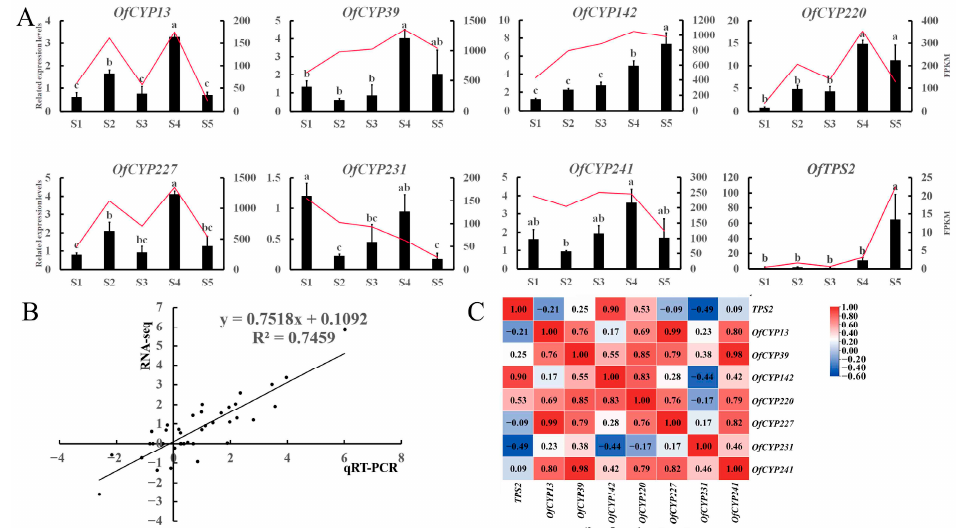
Figure 5. ( A ) Transcription levels of OfCYP s in different stages of sweet osmanthus flowers: S1, bud- pedicel stage; S2, bud-eye stage; S3, primary blooming stage; S4, full blooming stage; and S5, flower fading stage. The levels of transcription are the mean values of three biological samples, each sample had three technical replicates. The standard error (SE) was used to draw error bars. The different letters marked above the error bars denote the results of the significant differences analysis at p < 0.05 obtained using SPSS (version 25). ( B ) Correlation analysis chart of qRT-PCR and transcriptome data FPKM values. ( C ) Correlation analysis of expression of OfCYP s and OfTPS2 . Correlation coefficients from negative to positive correlation are indicated by a gradient from blue to red.